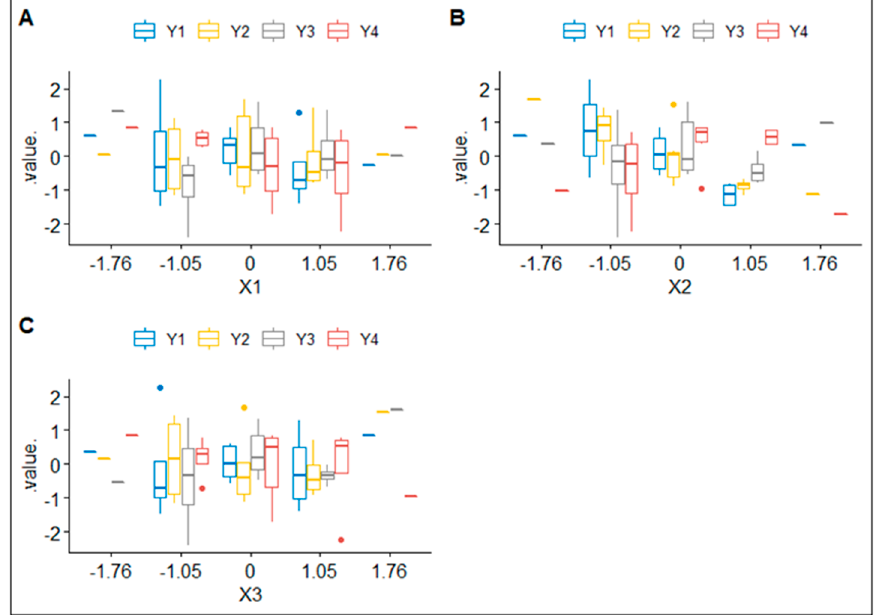
Figure 3. Boxplots of independent variables (cLS/LL, cPF and cTW) according to their corresponding dependent variables (Z-Ave (nm), Pl, ZP (mV) and EE (%)), represented in subfigures ( A – C ) respec- tively. X1, X2 and X3 denote cLS/LL, cPF and cTW, respectively, and Y1, Y2, Y3 and Y4 denote Z − Ave (nm), Pl, ZP (mV) and EE (%),